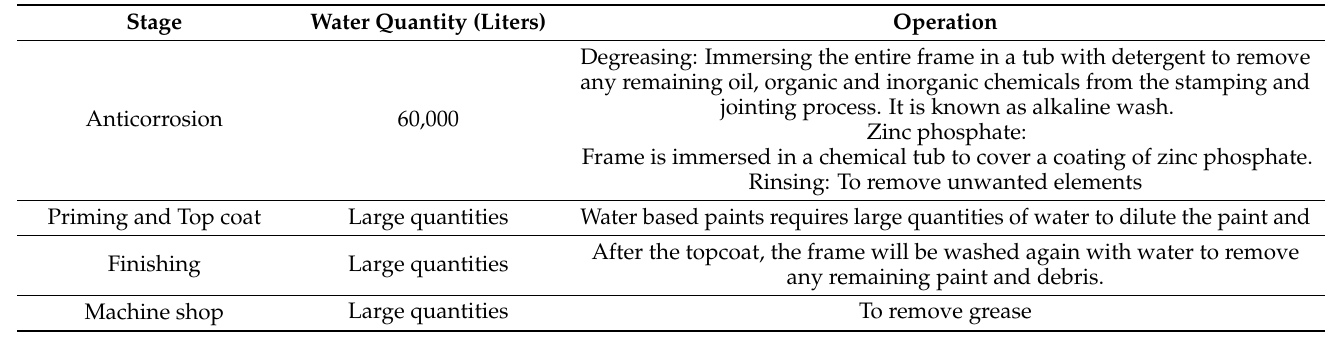
Table 3. Water usage in the manufacturing process.